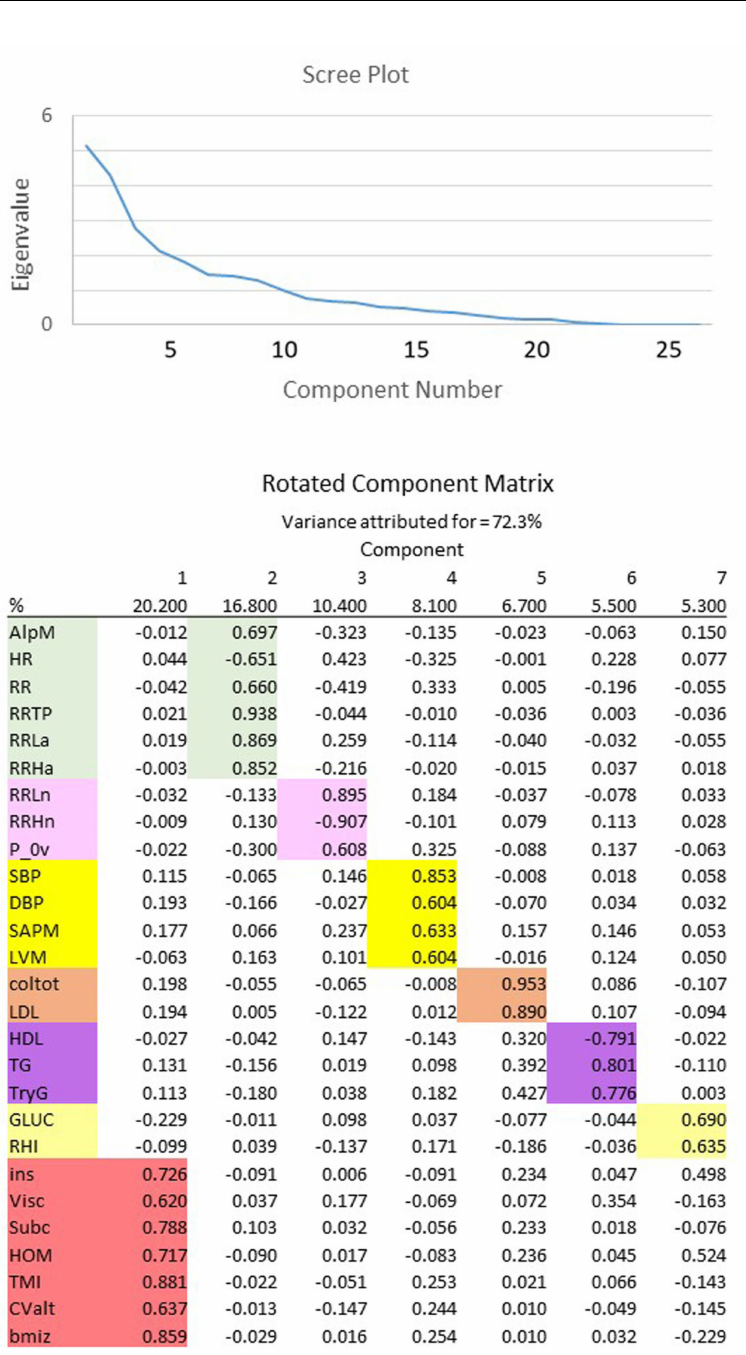
Figure 2. Exploratory factor analysis (EFA) of autonomic and metabolic indices from controls and patients. The seven hidden components that synthetize the reciprocal interrelations between autonomic nervous system regulation and metabolic indicators are reported in a different